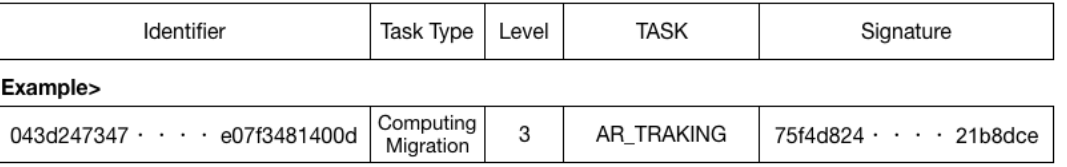
Figure 7. Computing type migration request message format and example.